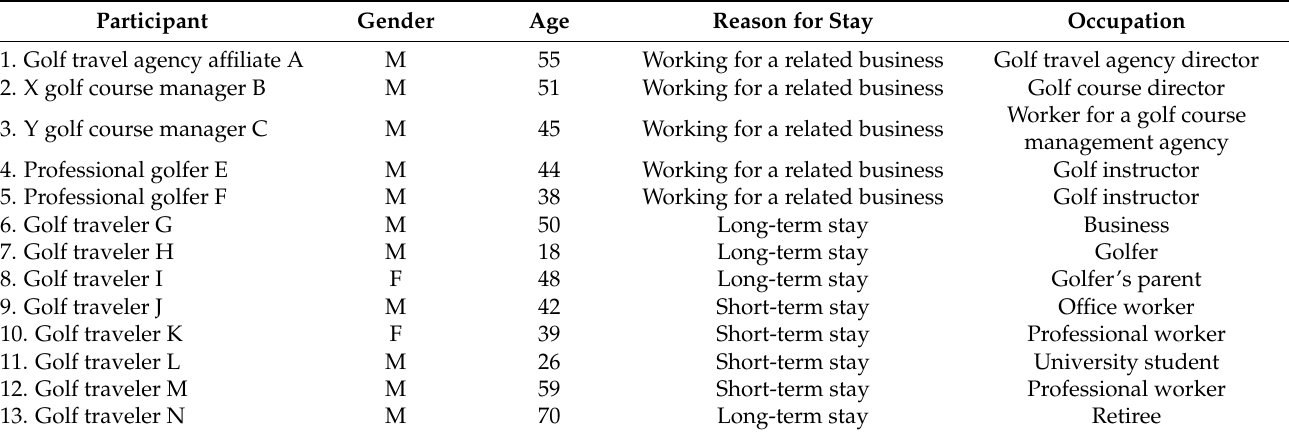
Table 7. General characteristics of the qualitative study participants.